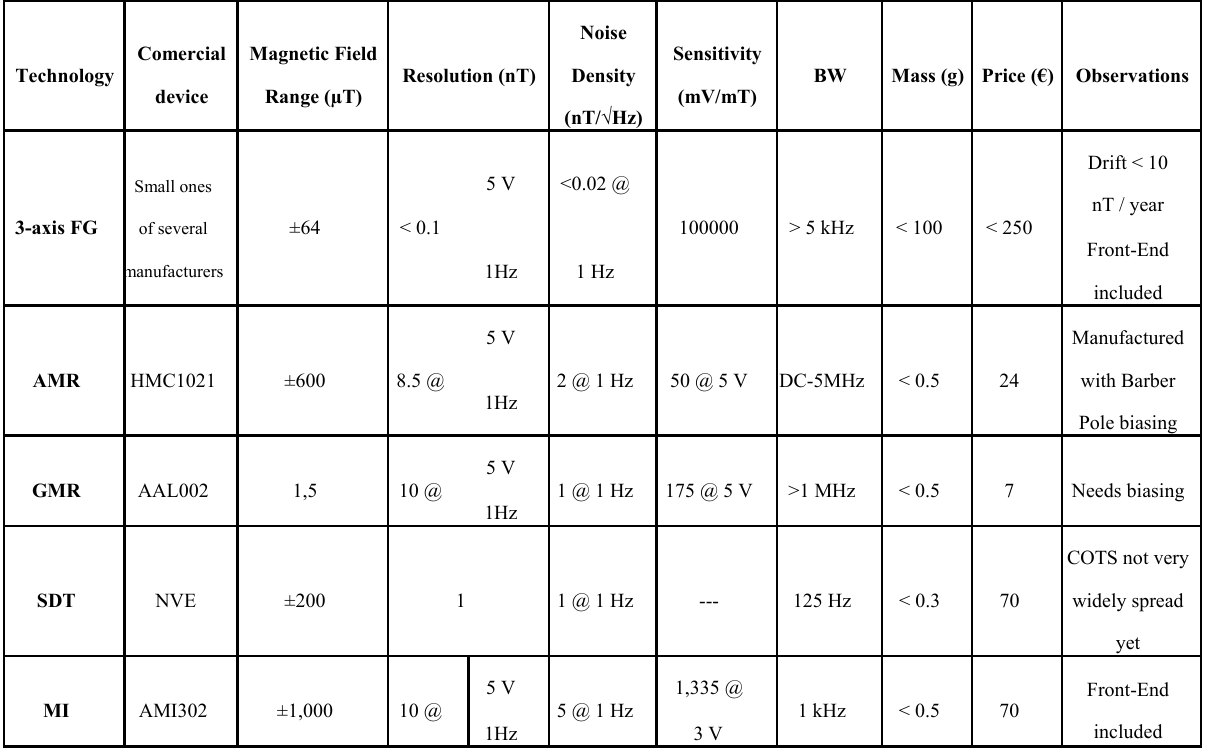
Table 1. Magnetic properties and approximate price of some commercial magnetic sensors suitable for space